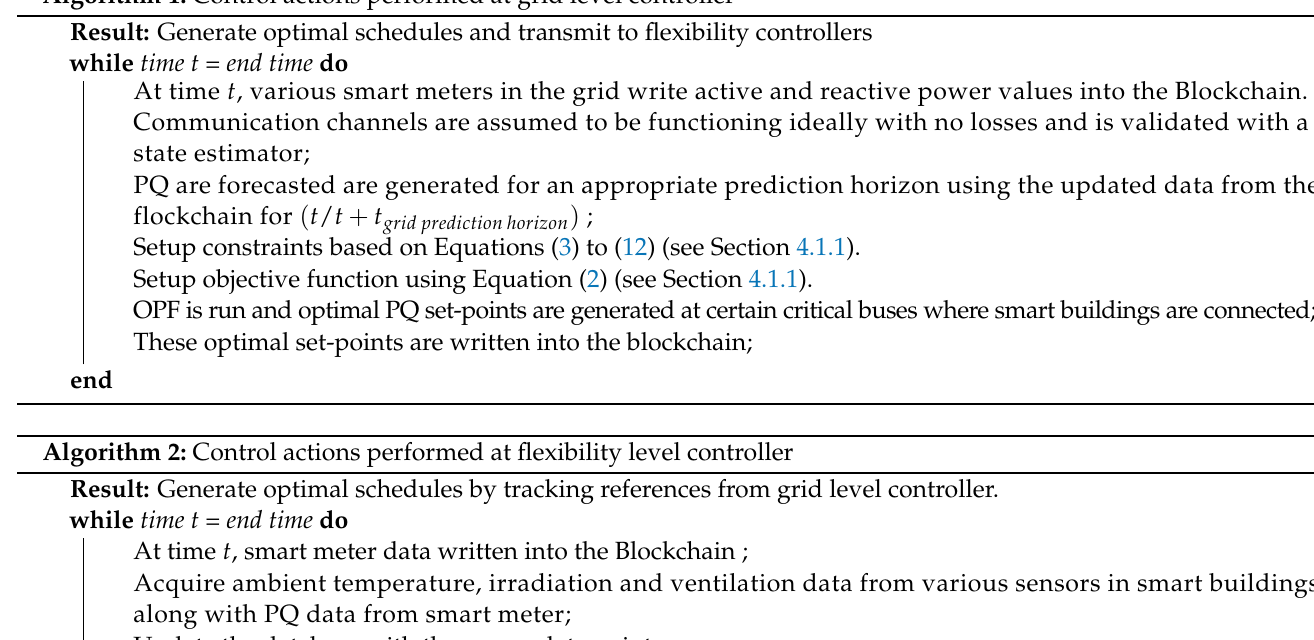
Algorithm 1: Control actions performed at grid level controller